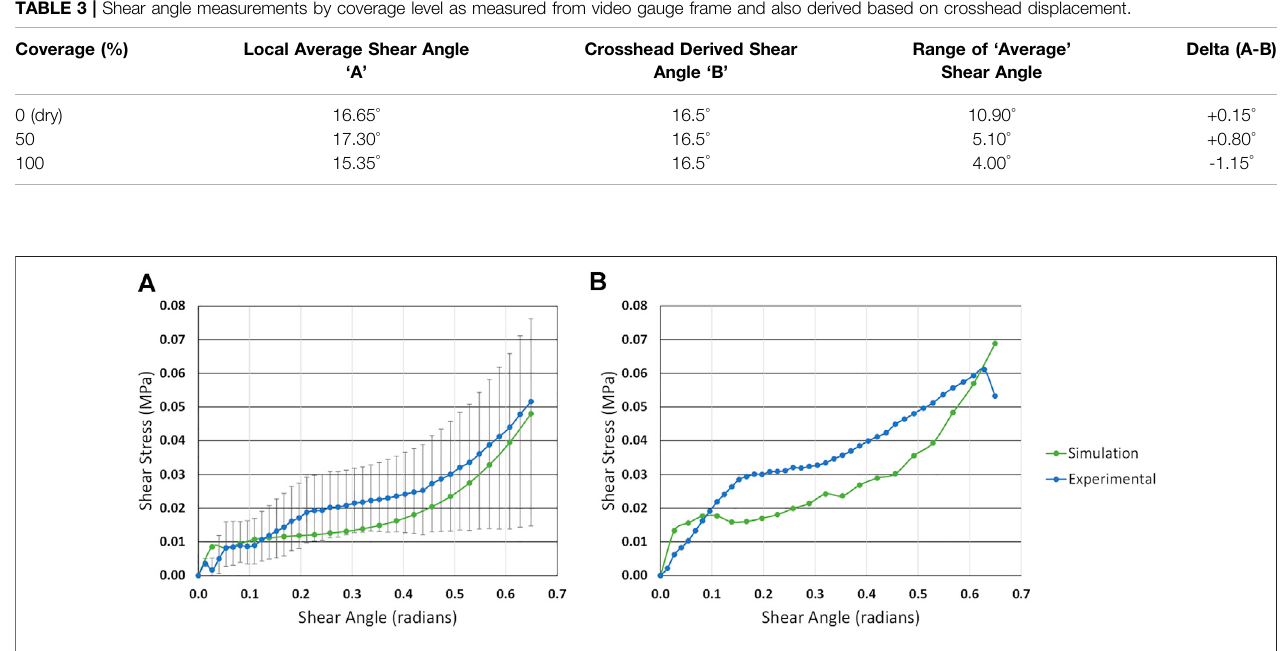
Frontiers in Materials |